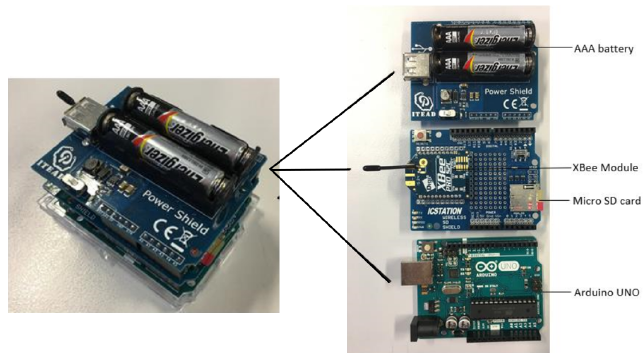
Figure 1. Components of the transceivers.